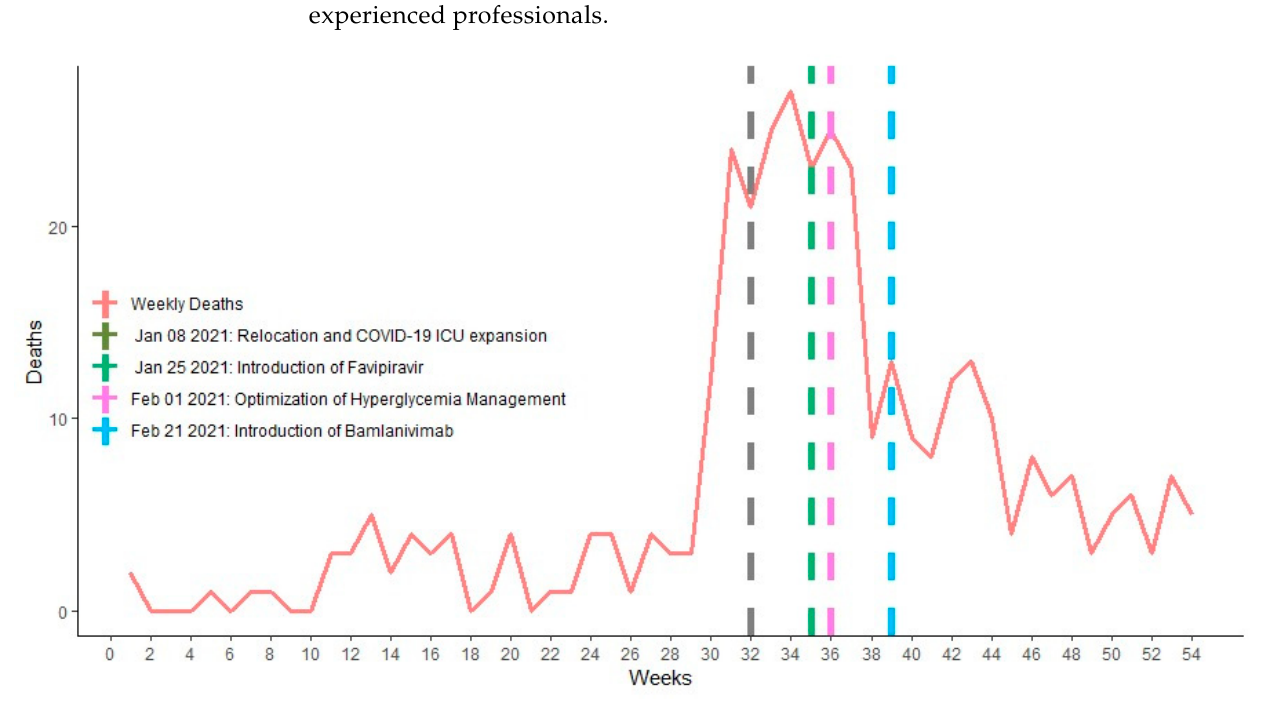
Figure 3. Major case management therapeutic interventions during COVID-19 deaths surge.